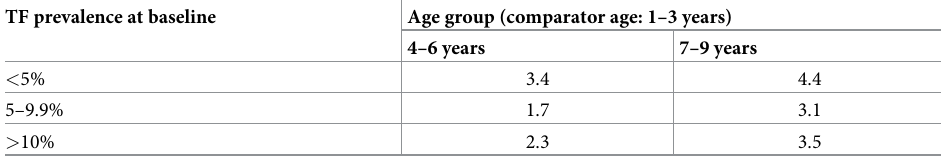
Table 4. Odds ratios for anti-Pgp3 seropositivity by ELISA, by evaluation unit-level baseline trachomatous inflammation—follicular (TF) prevalence and age of the individual, accounting for gender and EU. TF prevalence at